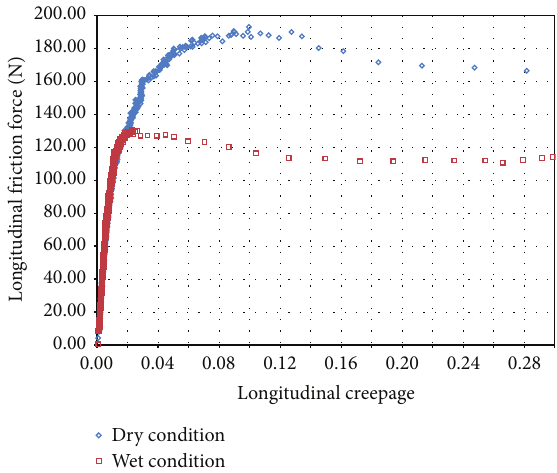
Figure 7: Creepage curve in wet and dry conditions considering a referencespeedof358 rpmandaverticalloadof42 kgoneachwheel.